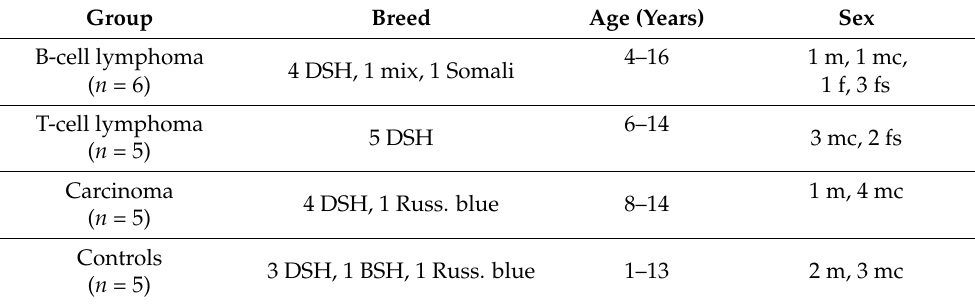
4–16 1 m, 1 mc, 6–14